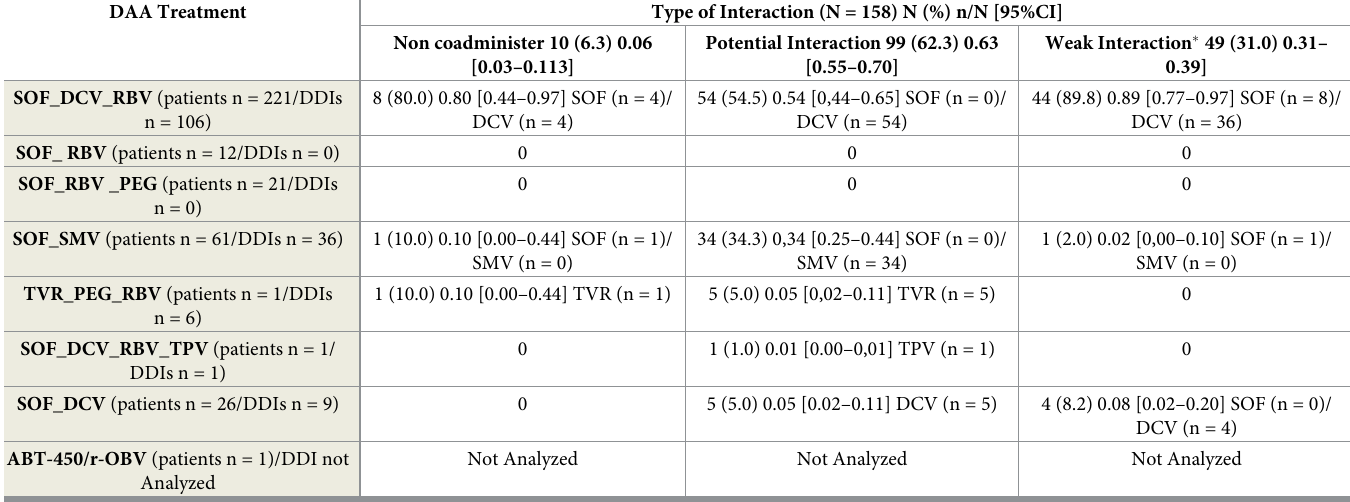
Table 2. Interactions with DAAs in the real life cohort.